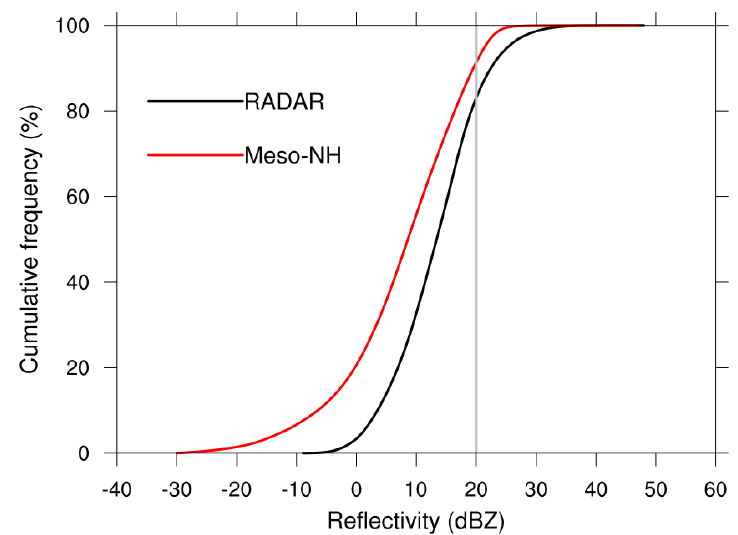
Figure 3. Cumulative distribution function of the maximum 2-D reflectivities from 03:00 to 08:00 UTC 24 July 2016 at 5-min temporal resolution on a 1-km grid for the X-band radar and Meso-NH computed inside the radar range. For the radar, 16.9% of the reflectivity values lie above 20 dBZ, whereas only 8.6% of the simulated reflectivity values exceed 20 dBZ.